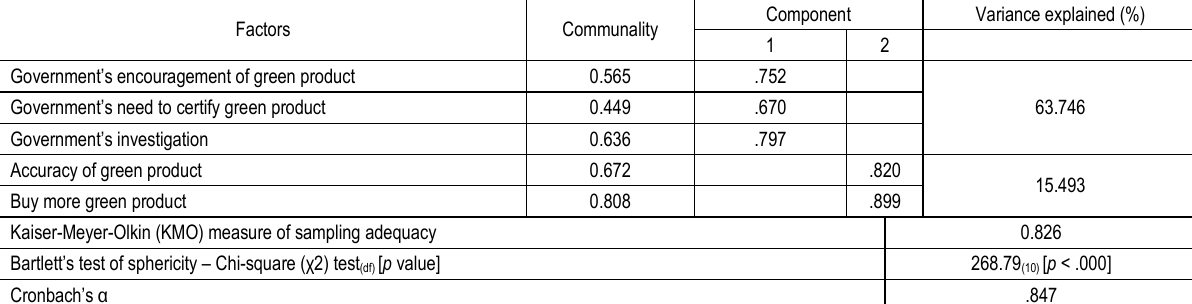
Table 6. Grade of the agreement and disagreement on green economy on the consumer